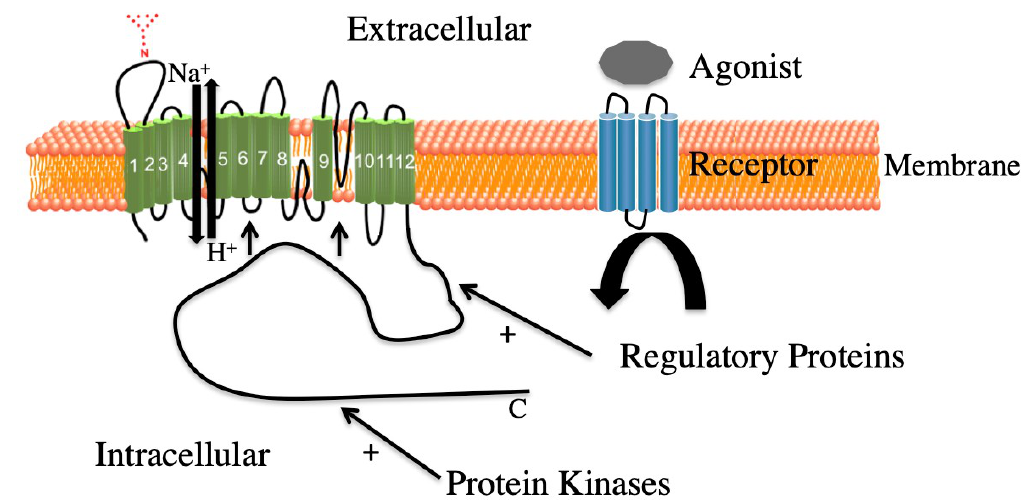
Figure 2. Regulation of Na + / H + exchanger isoform 1 (NHE1). Through agonists, receptor mediated activation of the Na + / H + exchanger, isoform 1, via protein regulatory interactions or through phosphorylation of the cytosolic C-terminus.